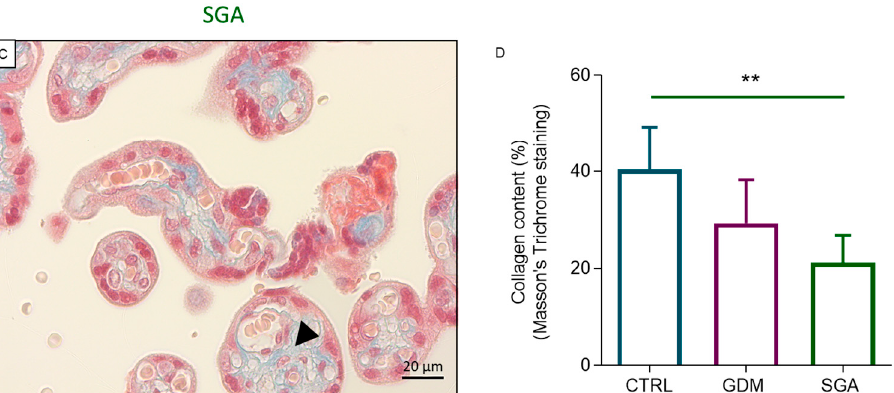
Figure 4. Collagen deposition analysis through histology in the three experimental groups. Masson’s Trichrome staining was performed to analyze the collagen deposition in the CVs ( A – C ). ( D ) Bars represent collagen deposition in the three conditions expressed as mean ± SD of five independent samples ( n = 5). Asterisks indicate significant differences (** = p < 0.01) Representative histological images of the collagen deposition within the CV (black arrowhead) in CTRL ( B ), GDM ( C ), and SGA ( D ) placentae. CTRL: control group (blue), GDM: gestational diabetes mellitus (purple), SGA: small-for-gestational-age (green).